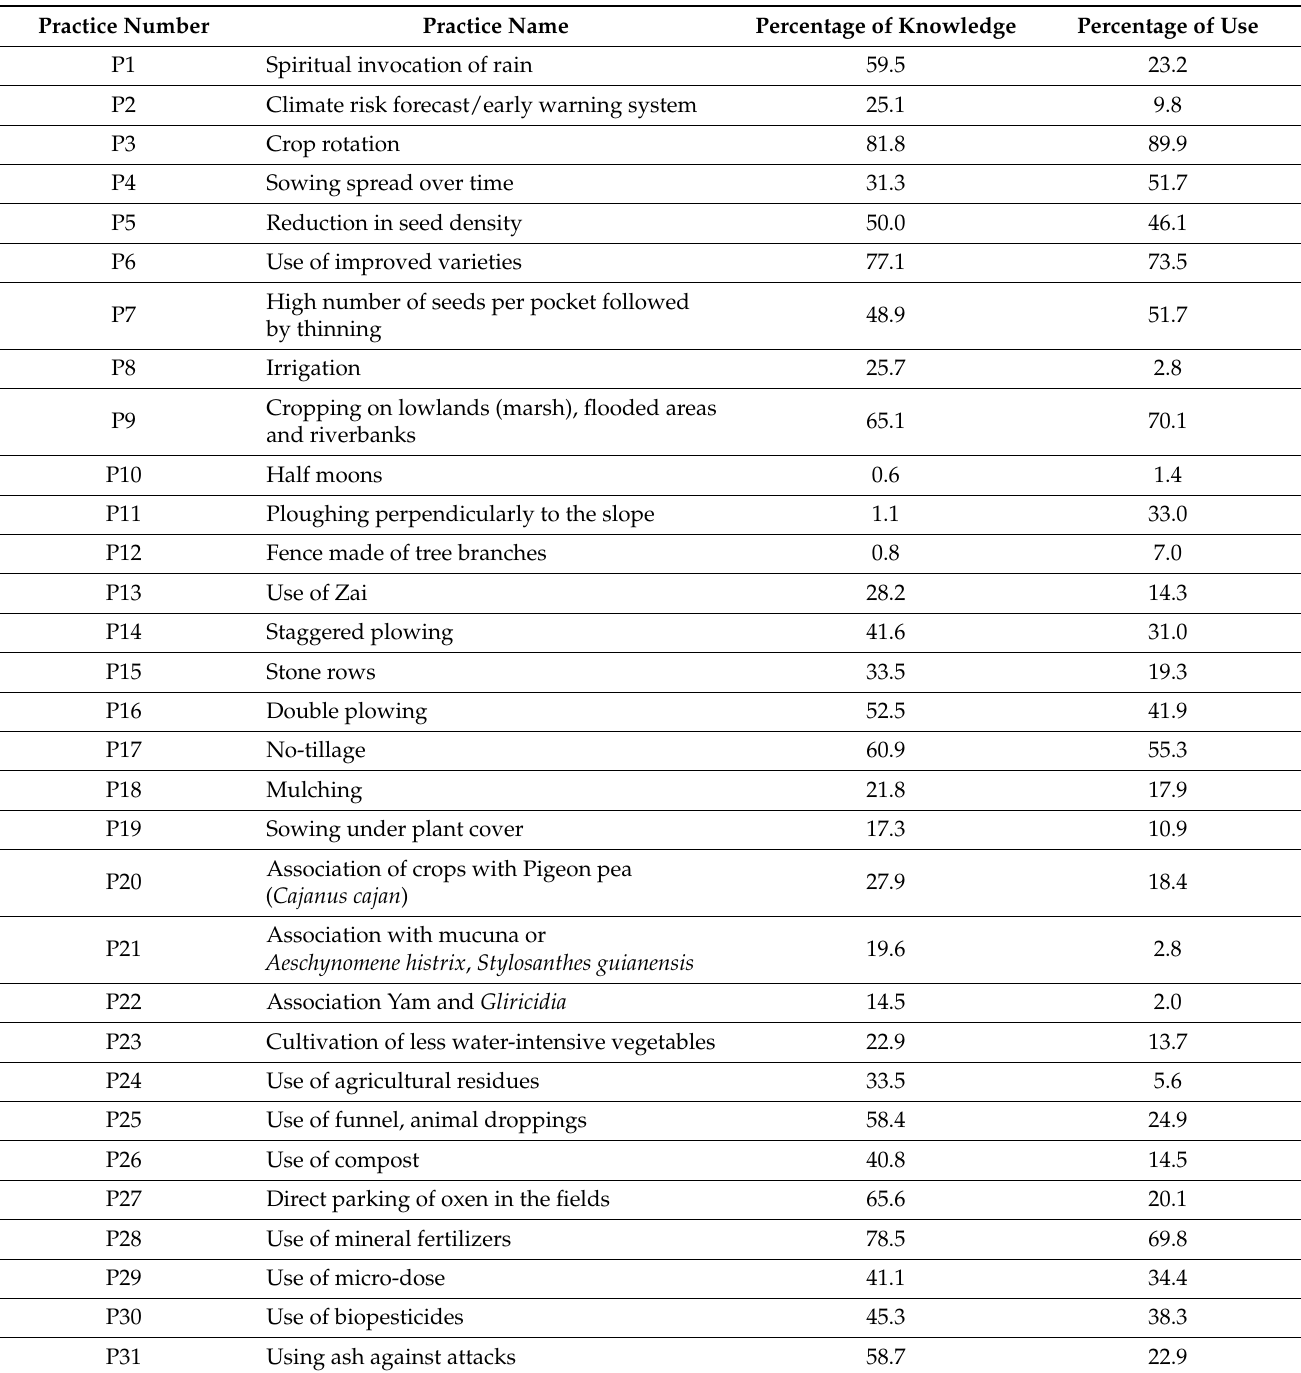
Table 1. Frequencies of awareness and use of